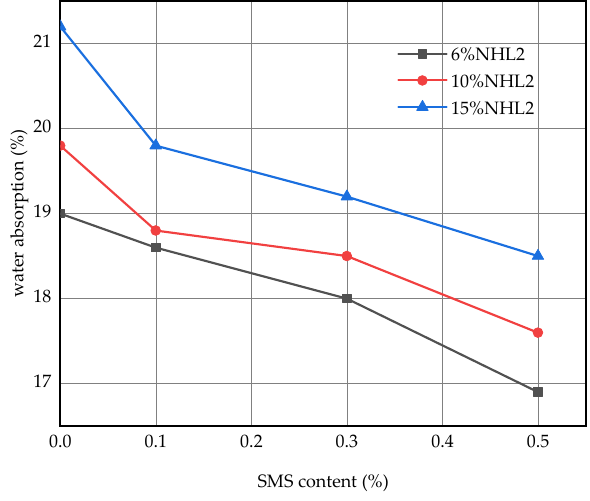
Figure 9. NHL2-SMS water absorption curve.